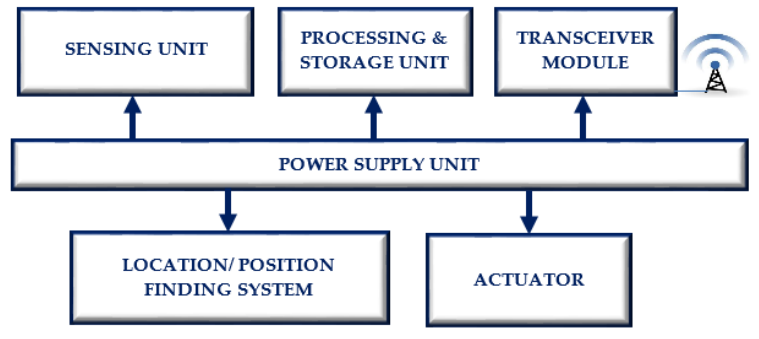
Figure 1. Architecture of WSN (Wireless Sensor Network)